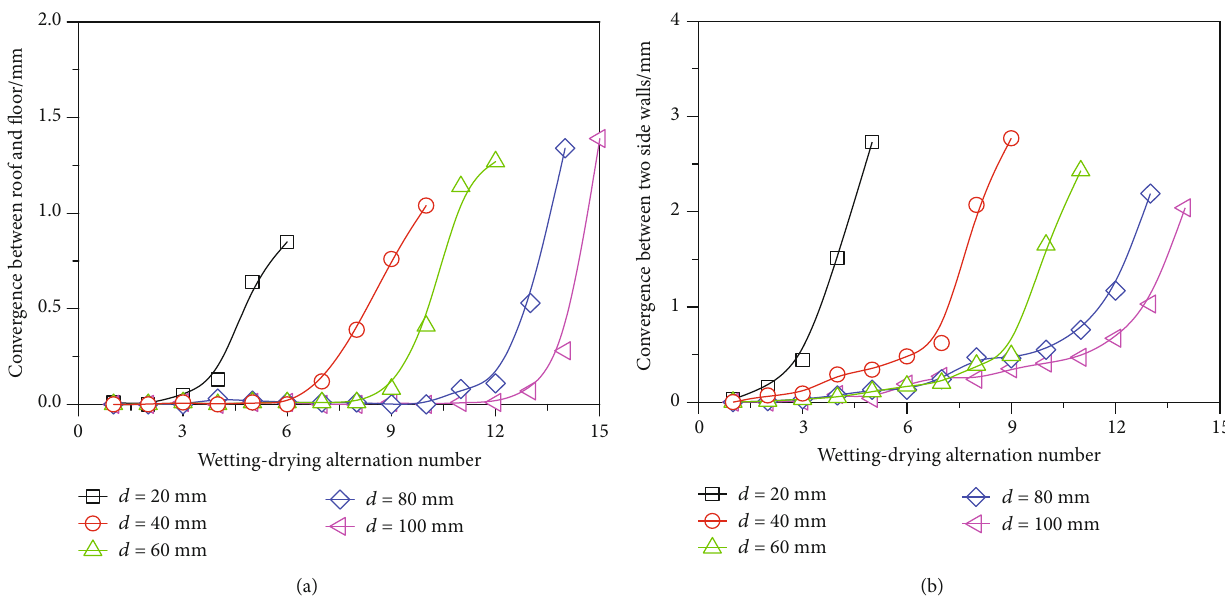
Figure 7: Variations in tunnel deformations with the increase of wetting-drying alternation number: (a) convergence between roof and fl oor and (b) convergence between two side